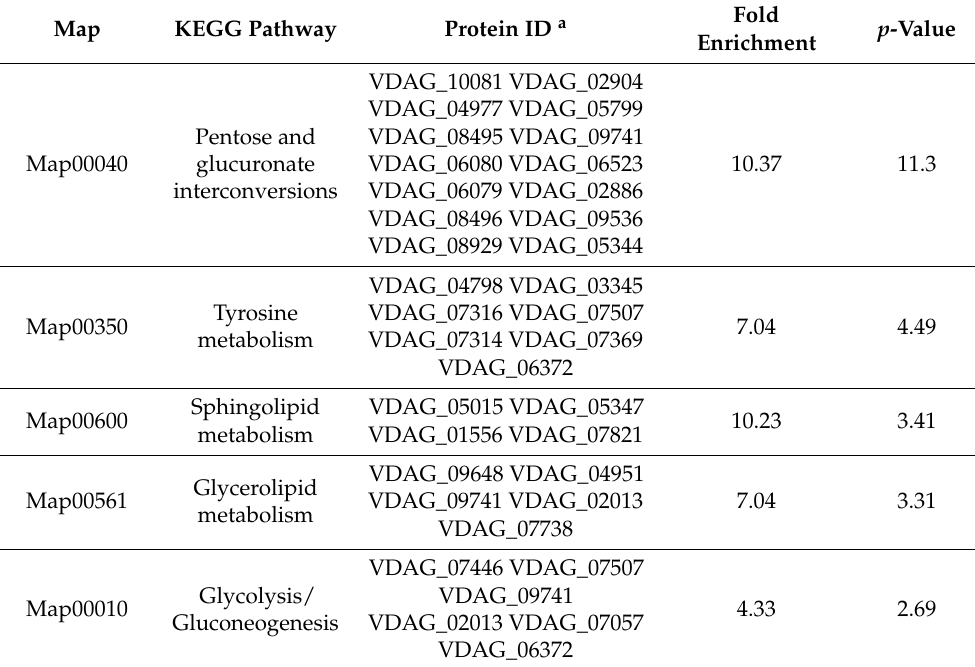
Figure 3. Enriched gene ontology (GO) terms, Kyoto encyclopedia of genes and genomes (KEGG) pathways, and protein domains of the proteins showing upregulated expression levels in the comparison groups. ( A ) Cellular components, molecular functions, and biological processes, ( B ) enriched KEGG pathways, and ( C ) enriched protein domains. Table 2. List of the proteins whose expression was upregulated in the Kyoto encyclopedia of genes and genomes (KEGG) pathways.